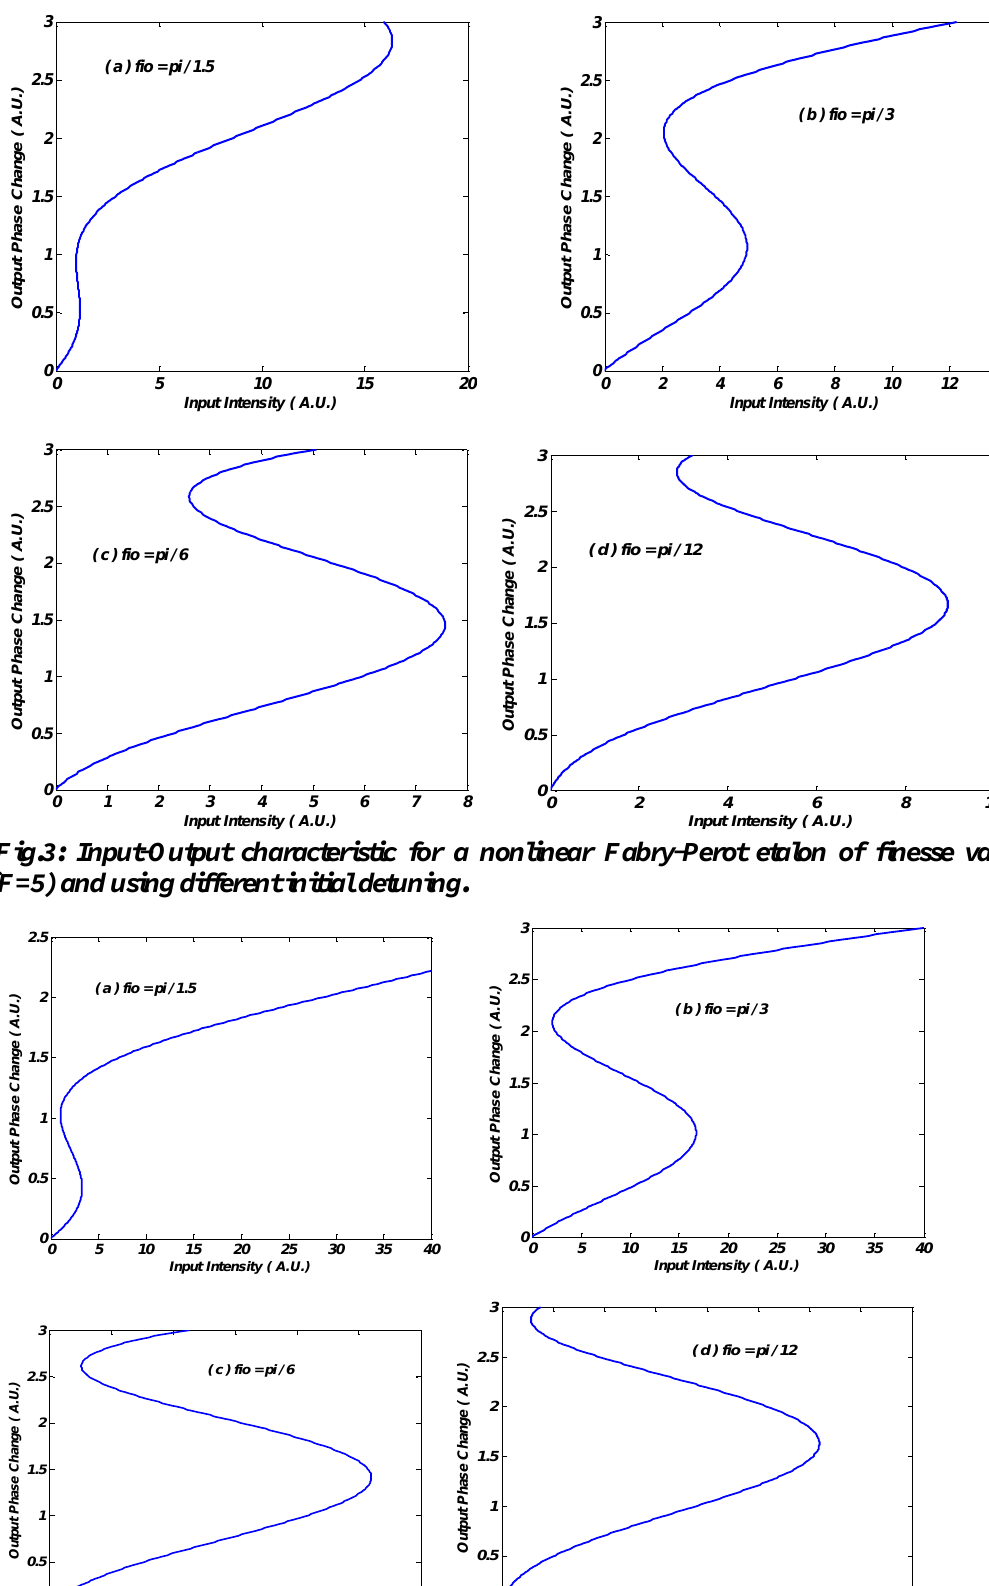
Fig.4: Input-Output characteristic for a nonlinear Fabry-Perot etalon of finesse value (F=20) and using different initial